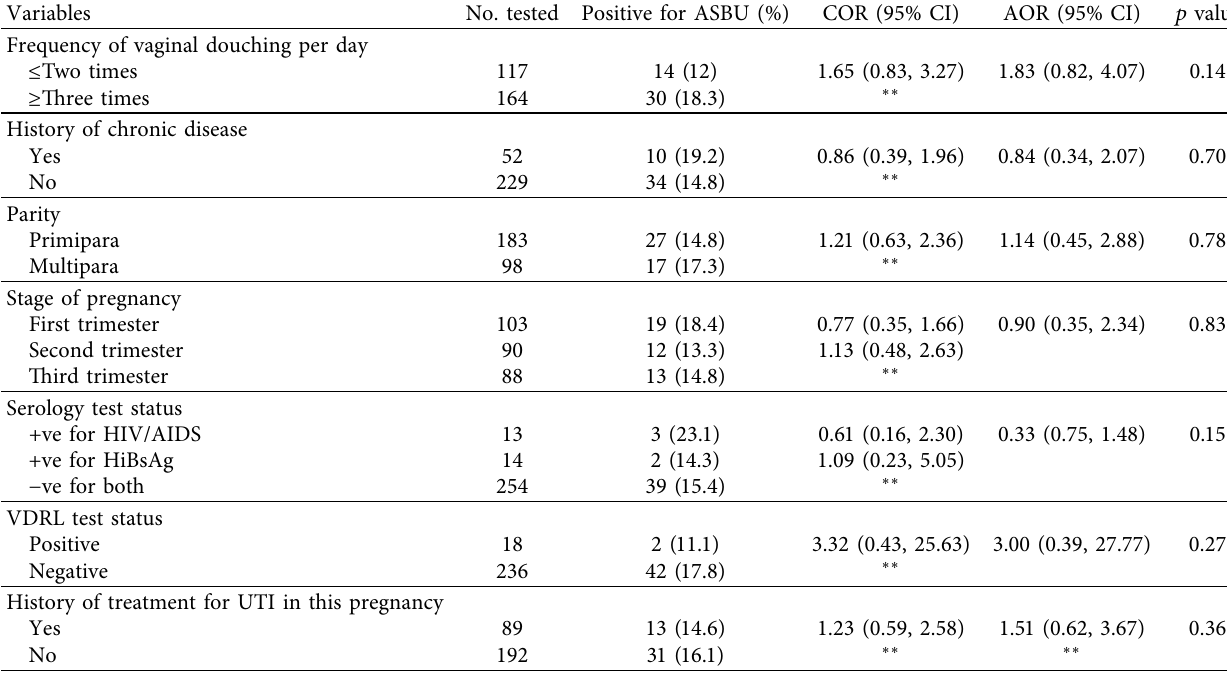
Table 2: Association of background and clinical characteristics with ASBU in pregnant women attending antenatal care services in Addis Ababa, Ethiopia ( N